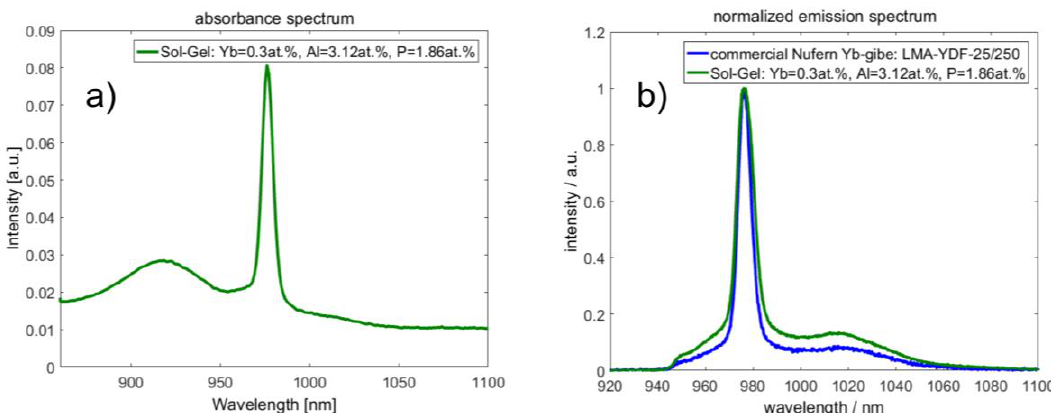
Figure 5. ( a ) Absorbance spectrum of the self-made sol-gel based fiber; and ( b ) emission spectra: self-made sol-gel based fiber and commercial Yb doped fiber (Nufern: LMA-YDF-25/250) [7].